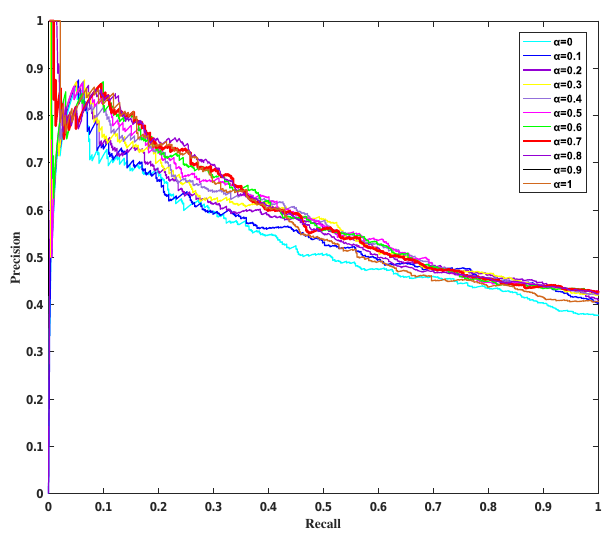
Figure 6. Precision–recall curves of HSEP with different α